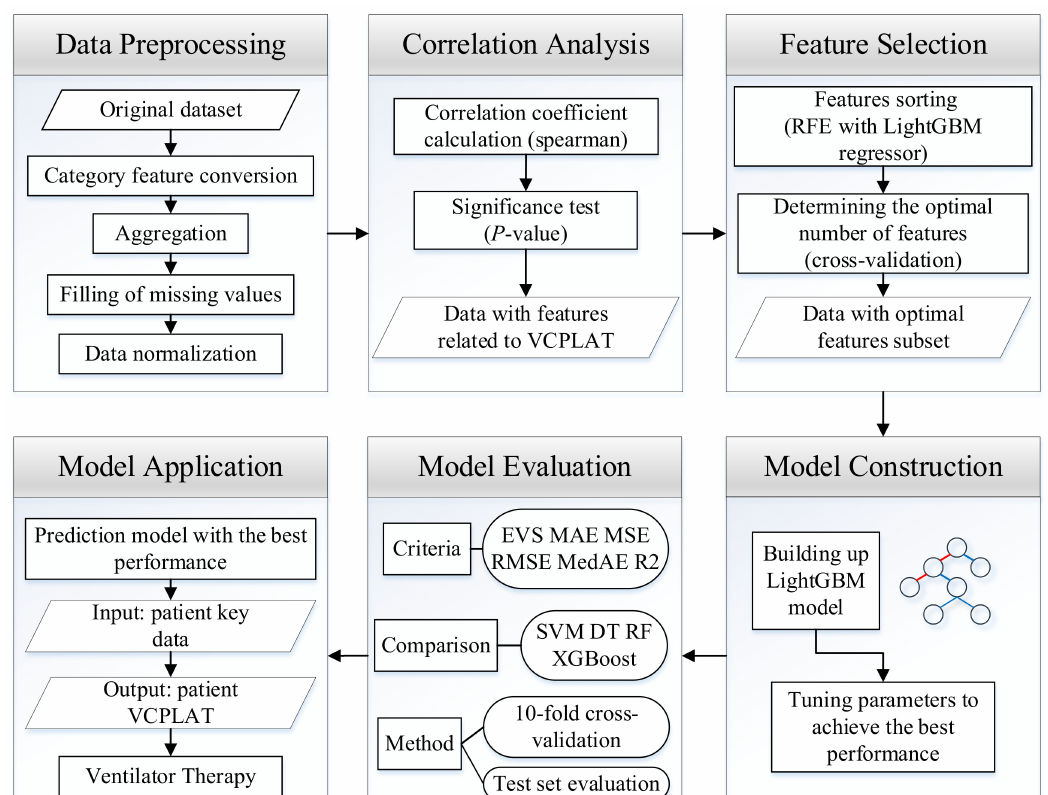
Figure 5. Prediction model construction process and